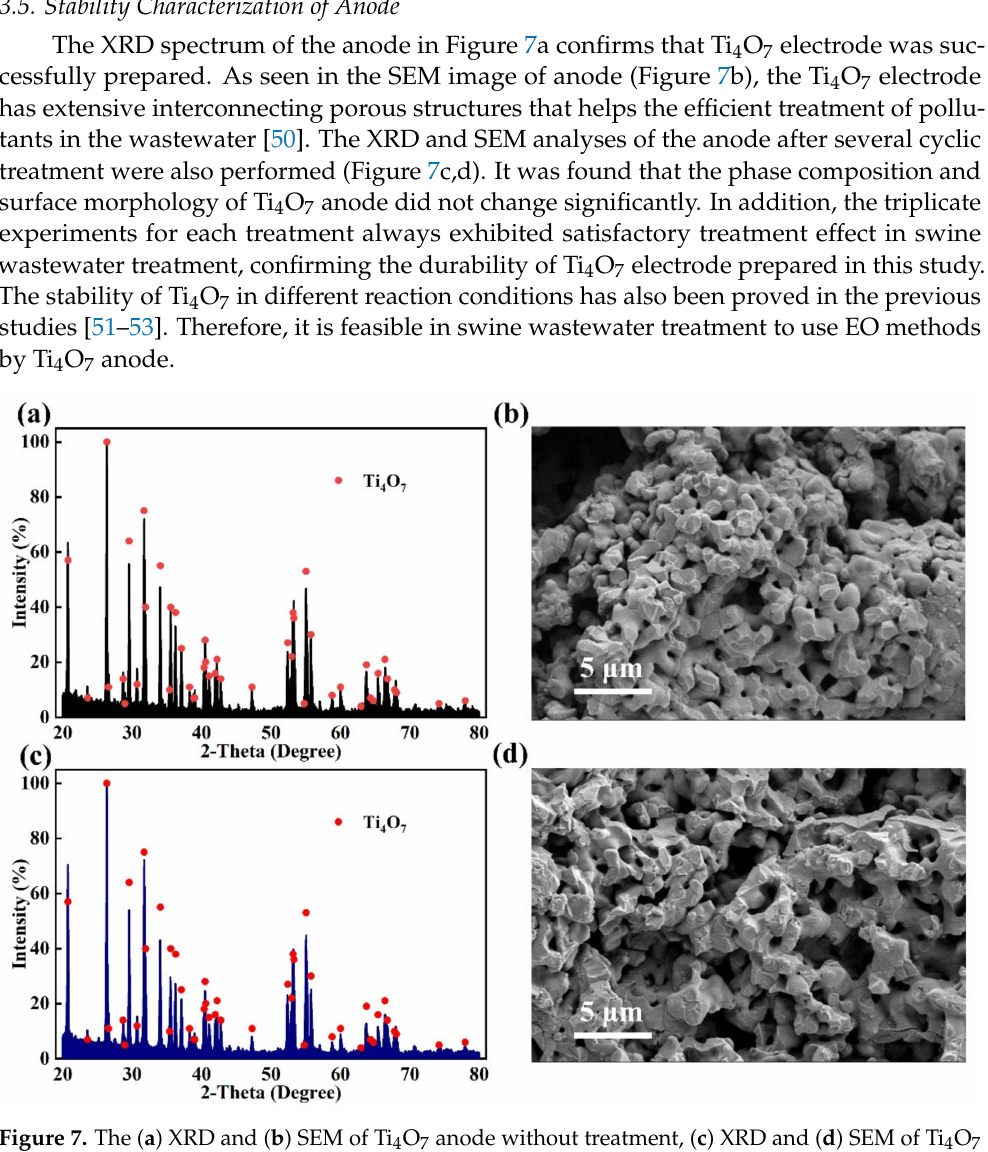
Figure 7. The ( a ) XRD and ( b ) SEM of Ti 4 O 7 anode without treatment, ( c ) XRD and ( d ) SEM of Ti 4 O 7 anode after several cyclic